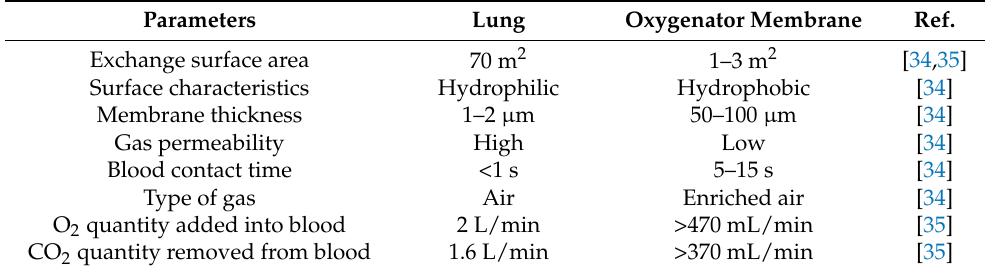
Table 1. Comparison of key parameters of human lungs and oxygenator membranes. Parameters Lung Oxygenator Membrane Ref. Exchange surface area 70 m 2 1–3 m 2 [34,35] Surface characteristics Hydrophilic Hydrophobic [34] Membrane thickness 1–2 µ m 50–100 µ m [34] Gas permeability High Low [34] Blood contact time <1 s 5–15 s [34] Type of gas Air Enriched air [34] O 2 quantity added into blood 2 L/min >470 mL/min [35] CO 2 quantity removed from blood 1.6 L/min >370 mL/min